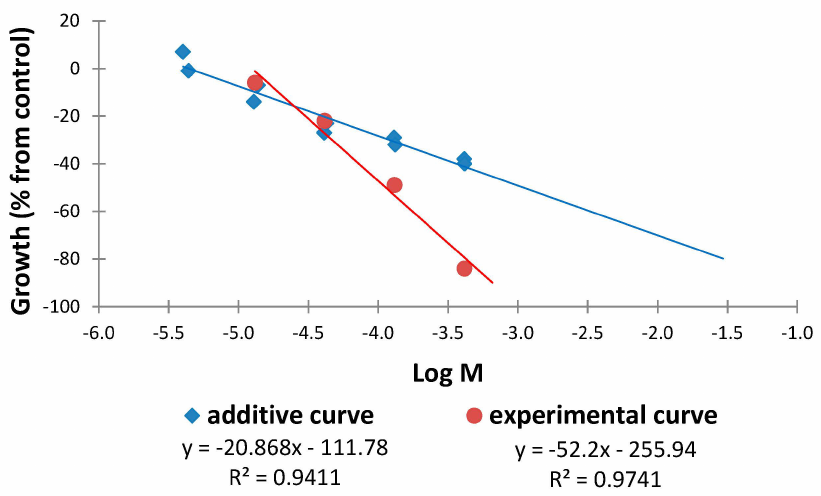
Figure 18. Comparison of the additive and experimental regression lines for the combination tetra- O -methylscutellarein ( 1 )/6,7,8,3 1 ,4 1 -pentamethoxyflavone ( 2 ) in a 1:1